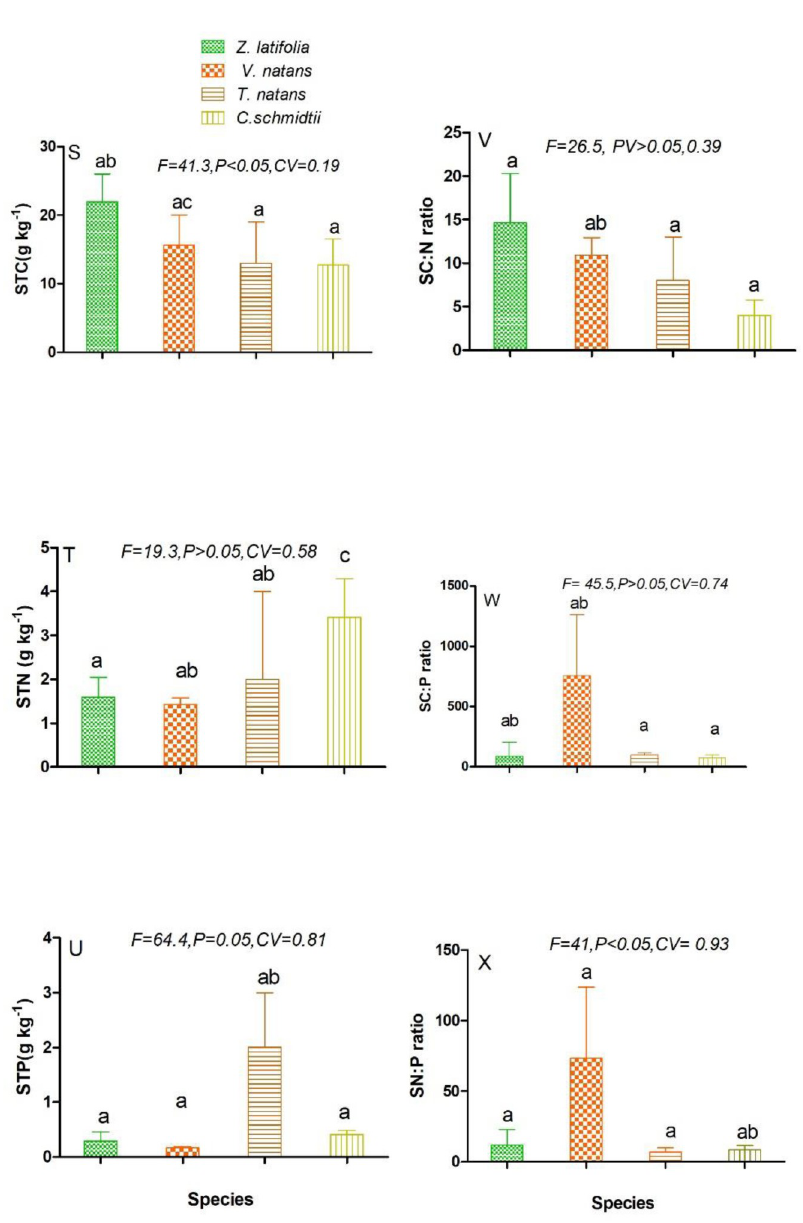
Fig 5. Ecological stoichiometric characteristics of stem C, N, P and their mass ratio among the four studied macrophytes species. STC-stem total carbon-(5S), STN-stem total nitrogen-(5T), STP- stem total phosphorus-(5U), SC: N- stem carbon to nitrogen ratio-(5V), SC: P- stem carbon to phosphorus ratio-(5W), SN: P-stem nitrogen to phosphorus ratio-(5X). Figures represent Mean ± SD, different letters show significant difference at p < 0.05. were displayed in (Fig 4P, 4Q and 4R) respectively. Similar to leaf and root nutrients, the con- centration of nutrients analysed in stem also noted variable. For instance, stem total nitrogen (STN) concertation measured high in C. schmidtii stem (Fig 5T) with no significant difference (F = 19.3, p > 0.05, CV = 0.58) contrarily to the remaining groups. Whereas, stem total phos- phorus concentration (STP) was found high in T. natans with slight significant difference (F = 64.4, CV, 0.81, P = 0.05) (Fig 5U).